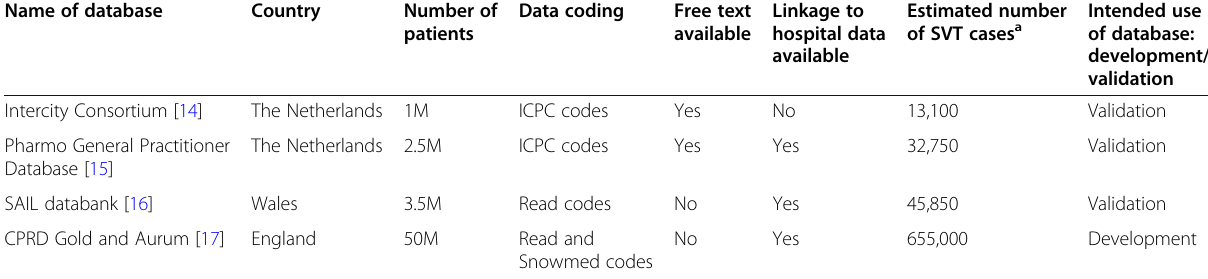
Table 1 Characteristics of primary care registry databases that will be approached for this study Name of database